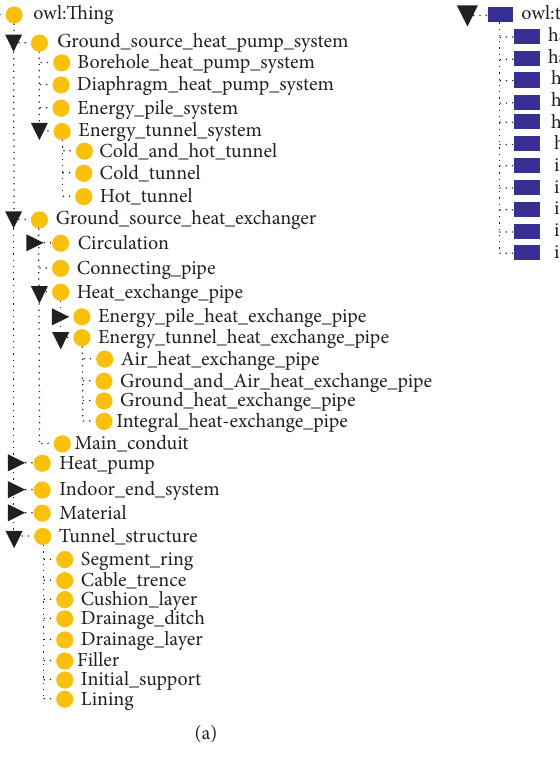
Figure 4: Class and property of developed